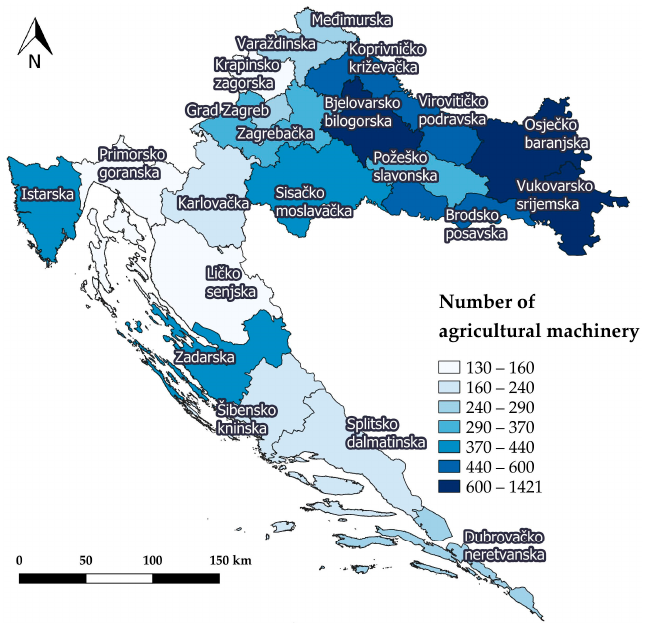
Figure 1. Spatial distribution of the number of respondents in the survey.